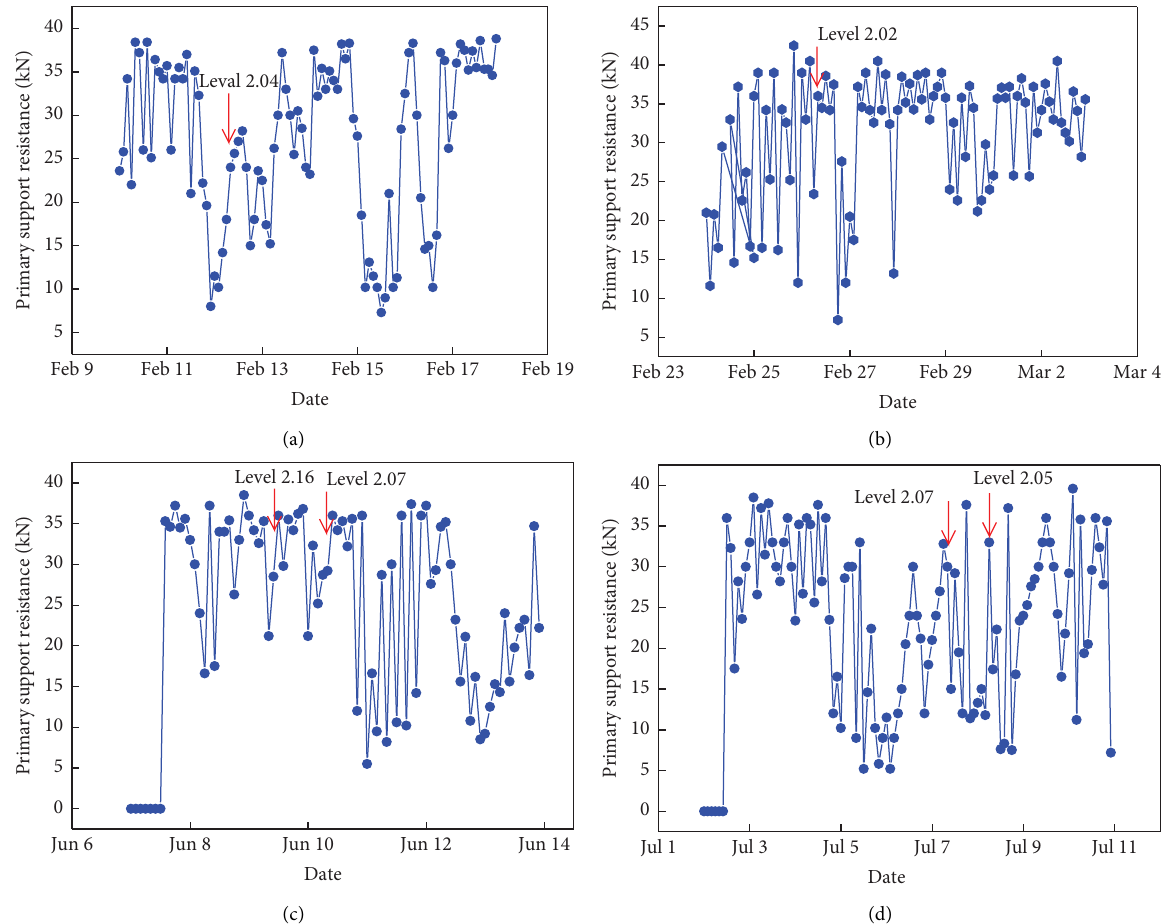
Figure 4: Support resistance before or after coal mine earthquakes. (a) February 12th. (b) February 26th. (c) June 9th and June 10th. (d) July 7th and July